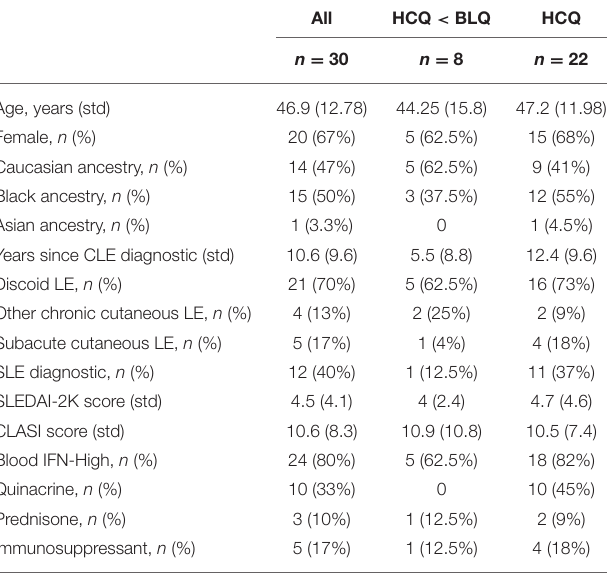
TABLE 1 | Characteristics of CLE patients included in